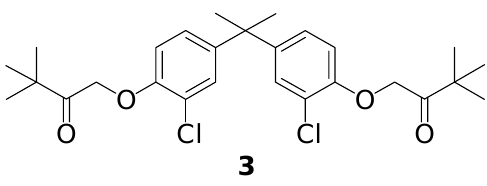
Figure 1. Non-steroidal analogue.